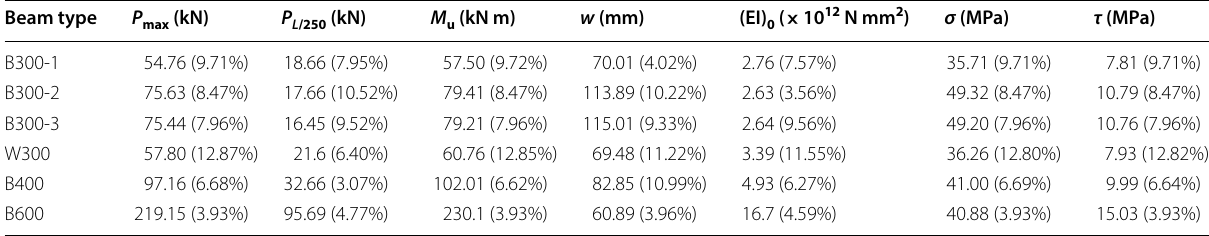
Values in parentheses are coefficient of variation